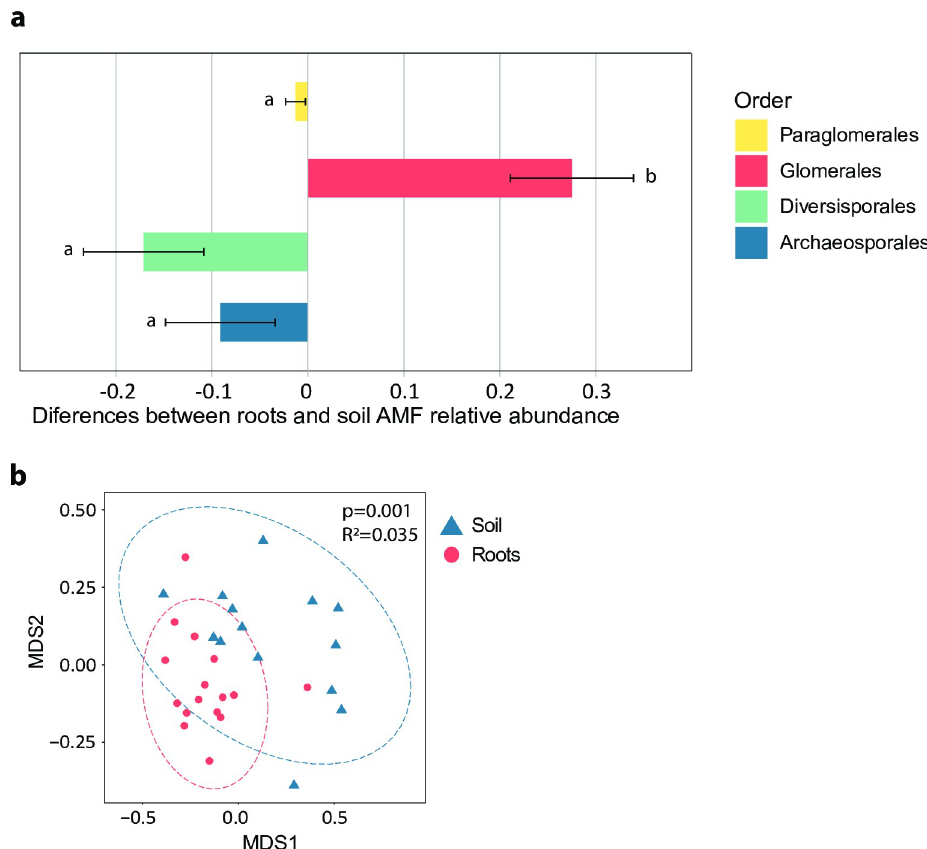
Fig 3. Differences in AMF community composition between root and soil samples. a) Means and standard error of the difference between the relative abundances of the AMF orders Archaeosporales, Diversisporales, Glomerales and Paraglomerales in soil and root samples. Positive values indicate that, on average, root samples had a higher relative proportion than their soil pairs, while negative values indicate the opposite trend. Different letters indicate significant differences between orders. b) Nonmetric multidimensional scaling (NMDS) ordination plots of arbuscular mycorrhizal fungal communities present in soil and roots compartments based on relative proportions of OTUs. Ellipses delimit the 95% confidence interval around